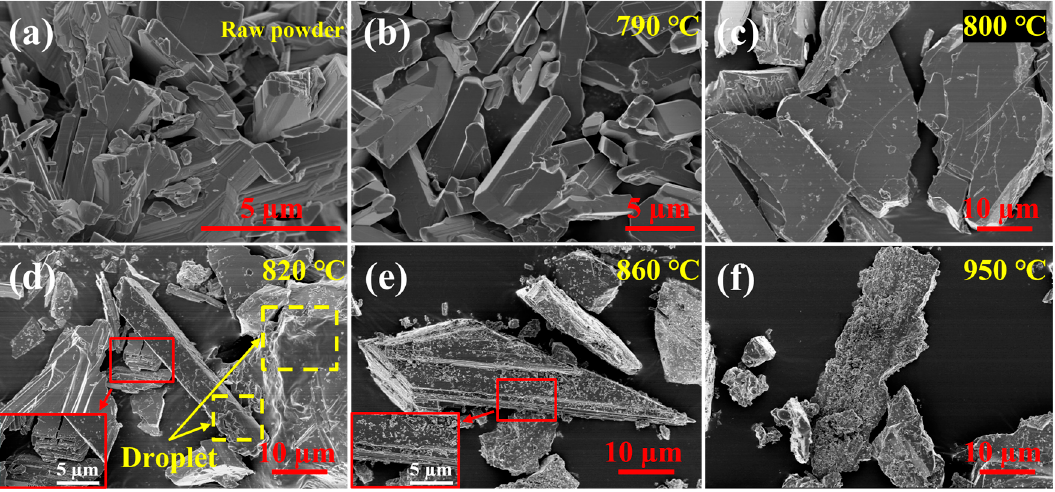
Figure 7. Surface morphologies of the Mo 9 O 26 raw powders ( a ) and them after heat treated at 790 °C ( b ), 800 °C ( c ), 820 °C ( d ), 860 °C ( e ) and 950 °C ( f ) for 1 h in fl owing argon.